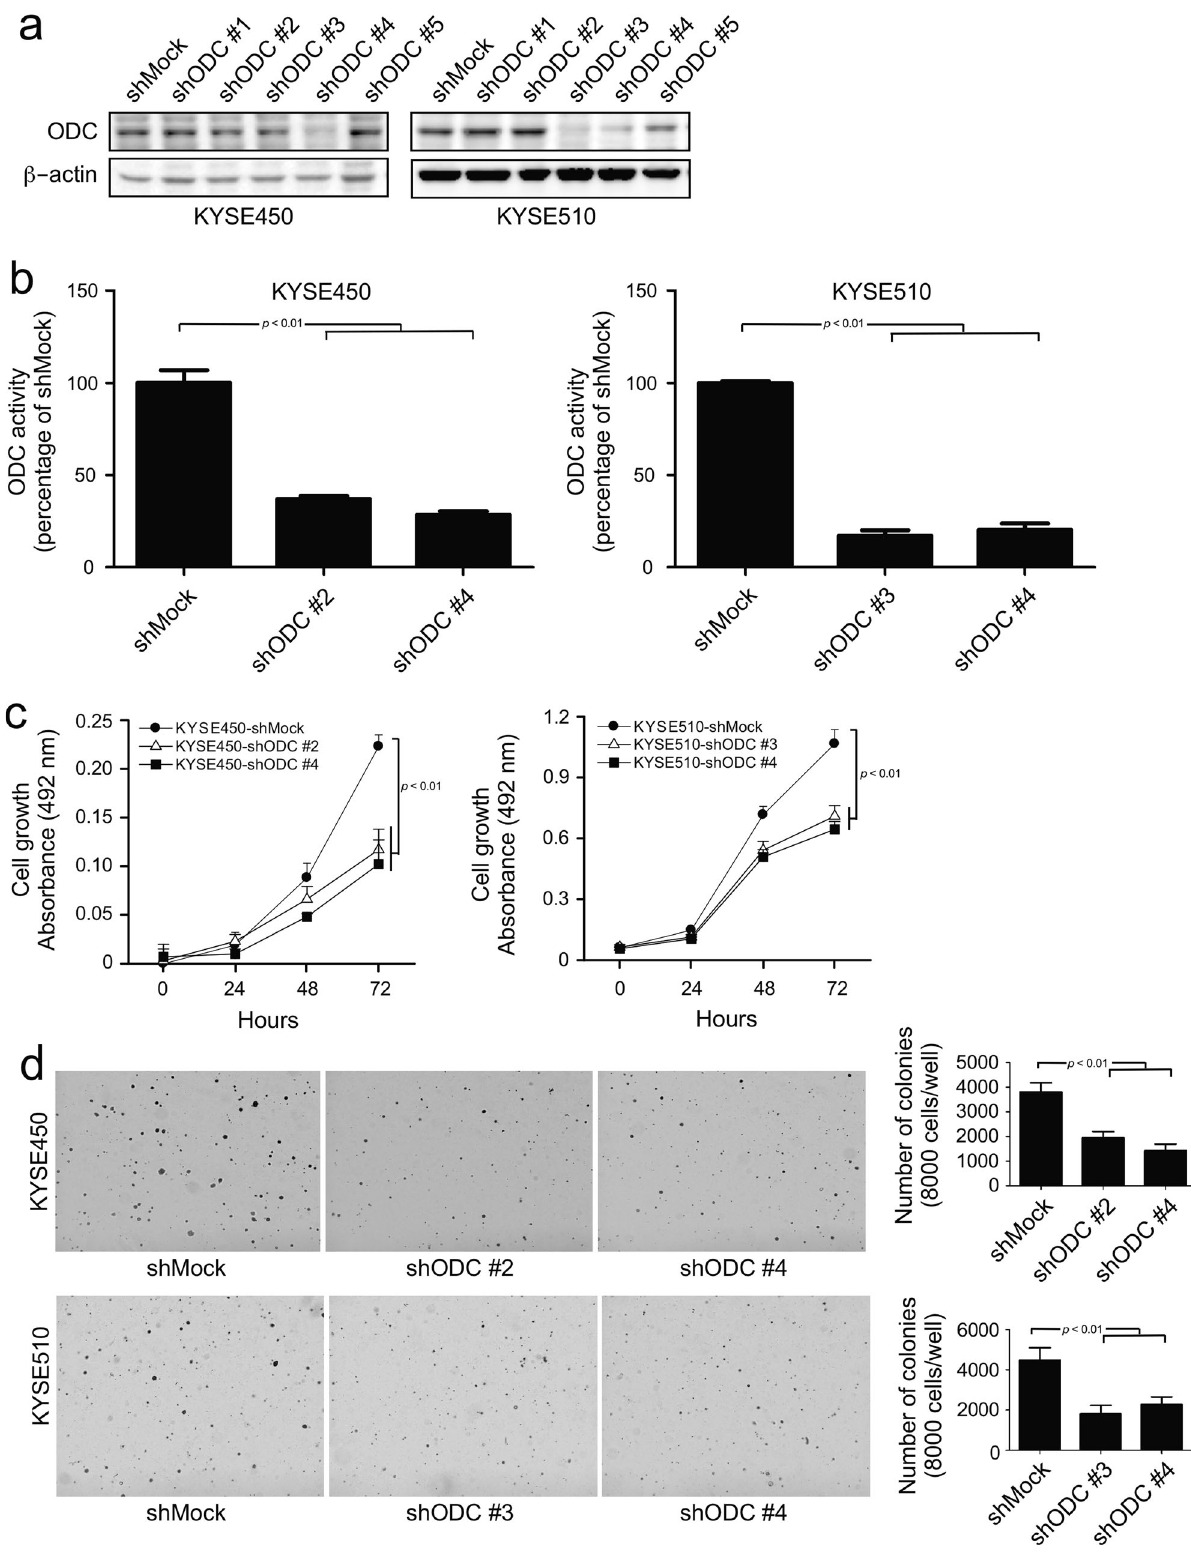
Fig. 2 Silencing ODC expression by shRNA suppresses anchorage-dependent and anchorage-independent ESCC cell growth. a ODC expression was analyzed by Western blot in KYSE450 and KYSE510 cells expressing shMock or shODC . b ODC activity was assessed as the release of L-[1-C 14 ] ornithine and results are shown as percentage of the control group (set at 100%). c Anchorage-dependent cell growth was measured by MTS assay. d For anchorage-independent growth, cells were cultured in soft agar for 3 weeks and then colonies were counted using a microscope and the Image-Pro Plus software (v.6.0) program. All data are shown as means ± S.D. of triplicate values from 3 independent